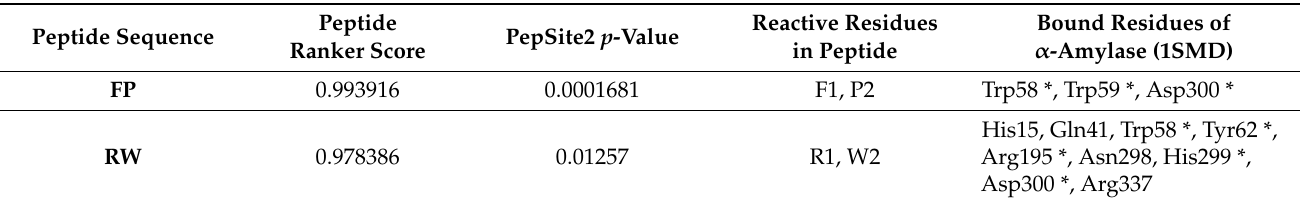
Table 4. Biologically active peptides from a selected lupin protein hydrolysate (ACT) and their binding potential with α -amylase (1SMD) as a protein